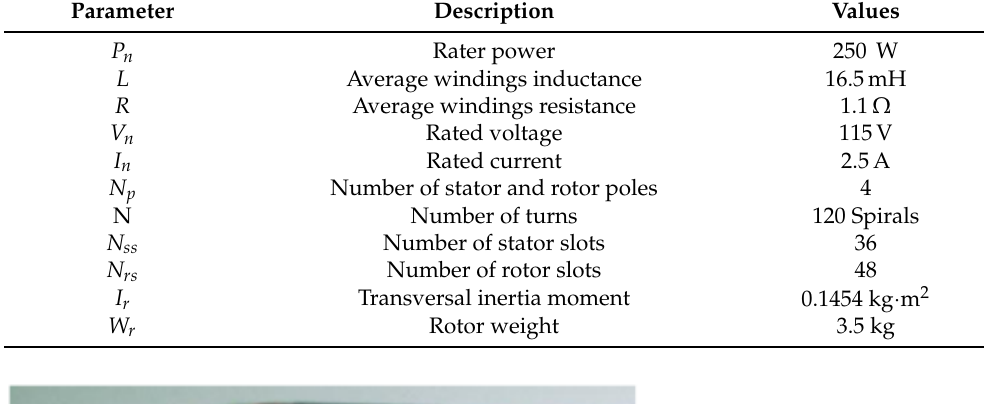
Table 1. Bearingless Induction Machine Parameters.